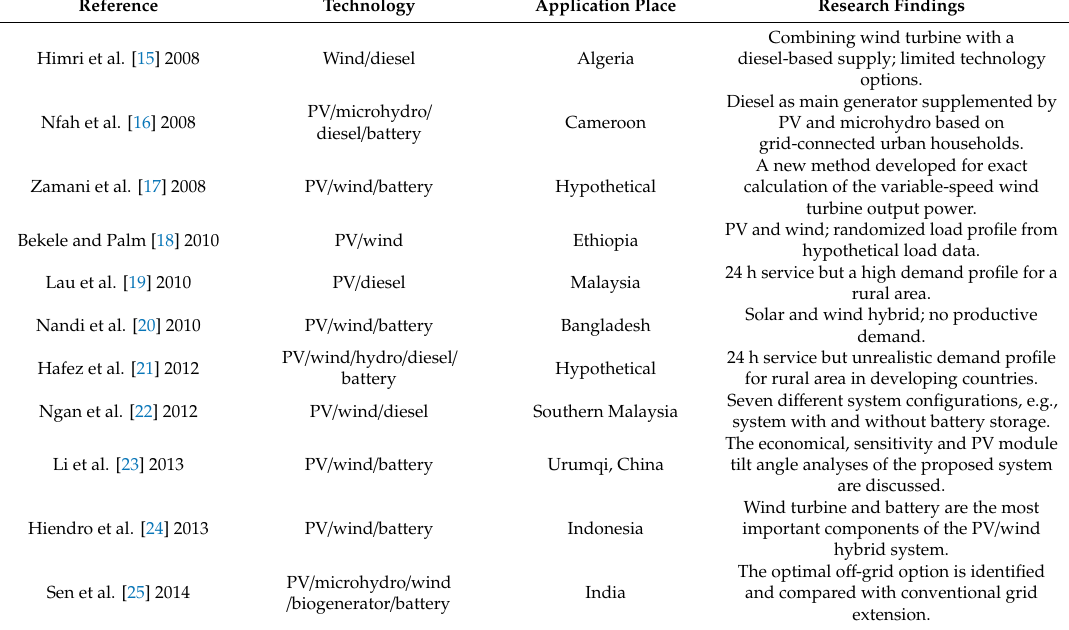
Table 1. The relevant researches on hybrid systems by using Hybrid Optimization Model for Electric Renewable